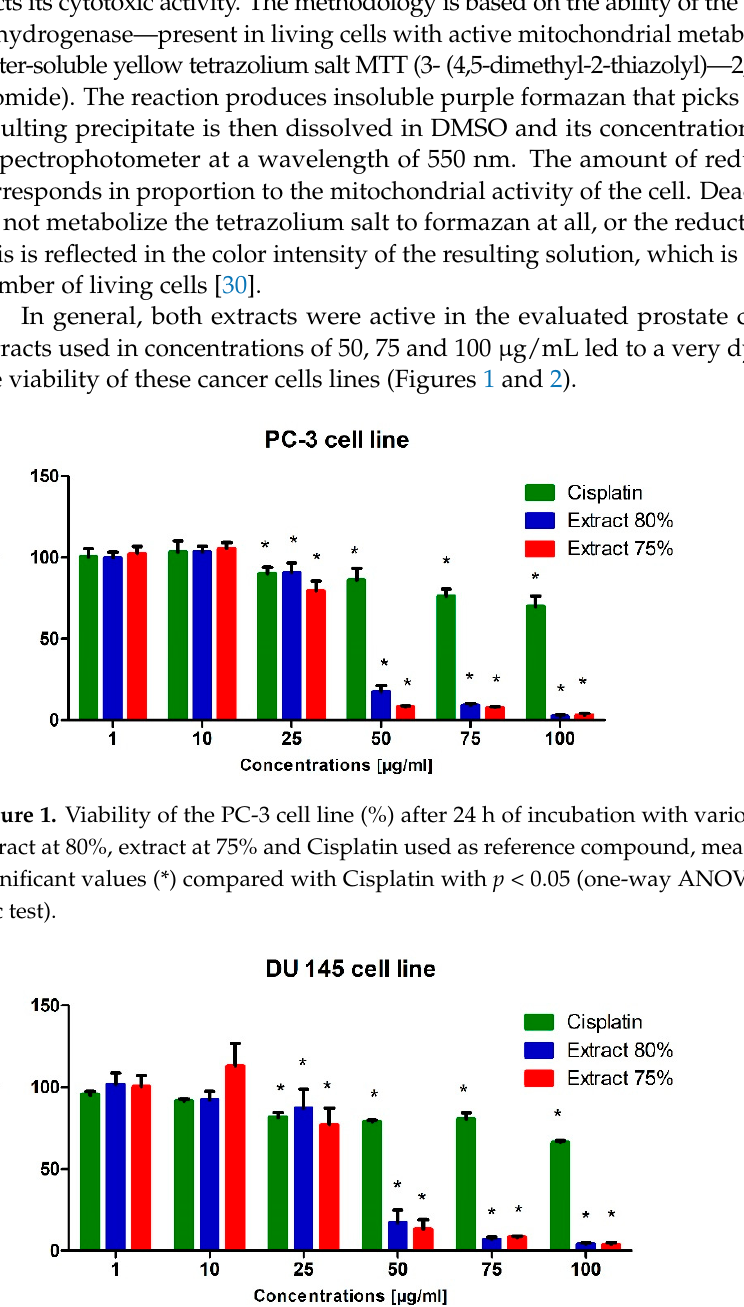
Figure 3. Viability of the WS1 cell line (%) after 24 h of incubation with various concentrations of extract at 80%, extract at 75% and Cisplatin used as reference compound, measured with MTT test; Significant values (*) compared with Cisplatin with p < 0.05 (one-way ANOVA with Tukey’s post hoc test). 2.2. Cell-Death Assessment/Apoptosis Analysis